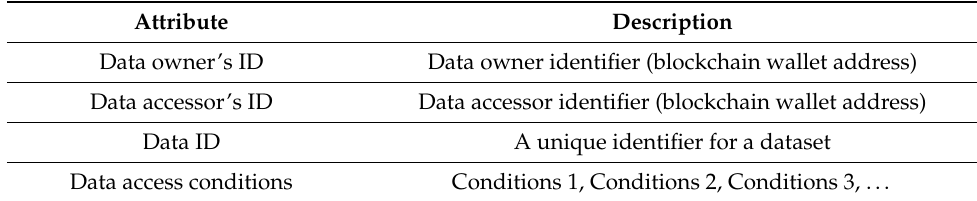
Table 1. Consent representation. Attribute